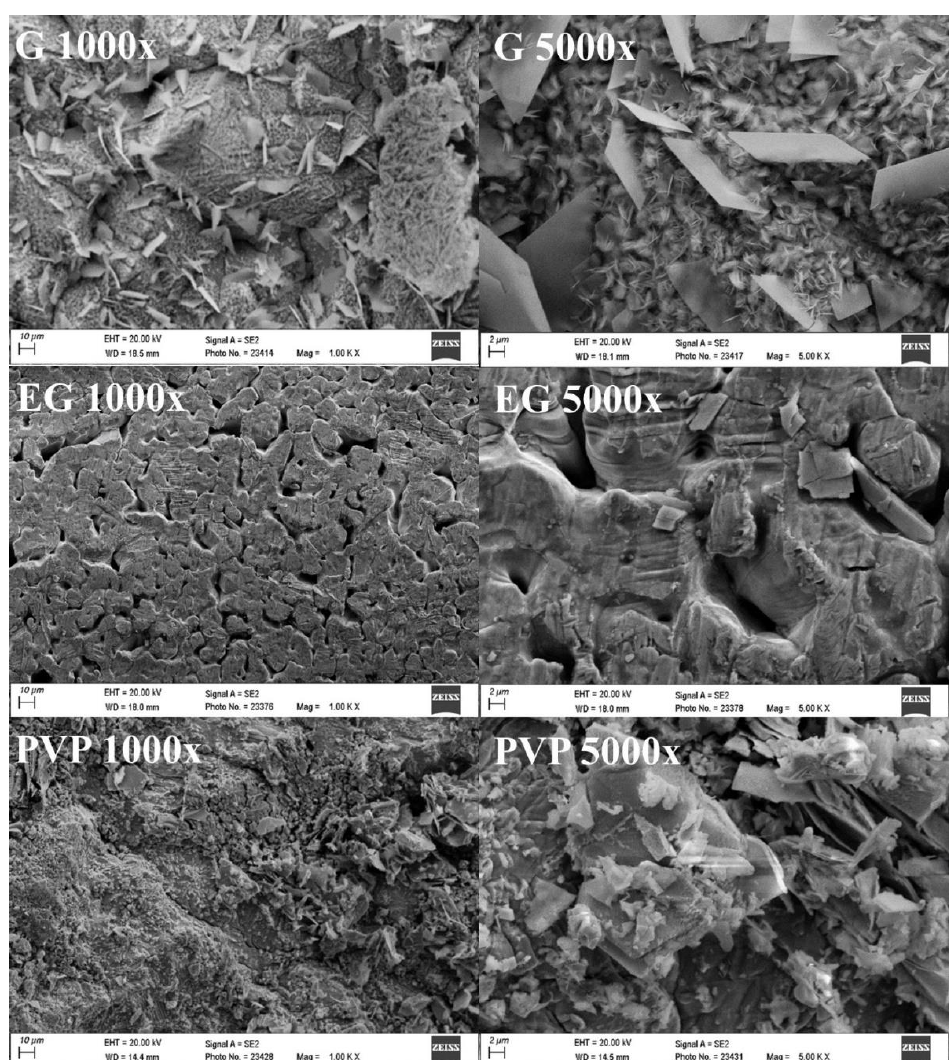
Figure 10 . SEM images of lead deposits produced using different inhibitors